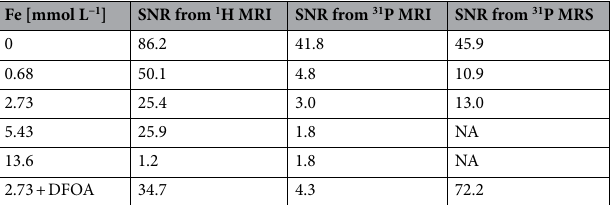
Table 1. Signal-to-noise ratios (SNR) from 1 H, 31 P-MRI and 31 P-MRS measured on a 4.7 T scanner. NA not applicable.